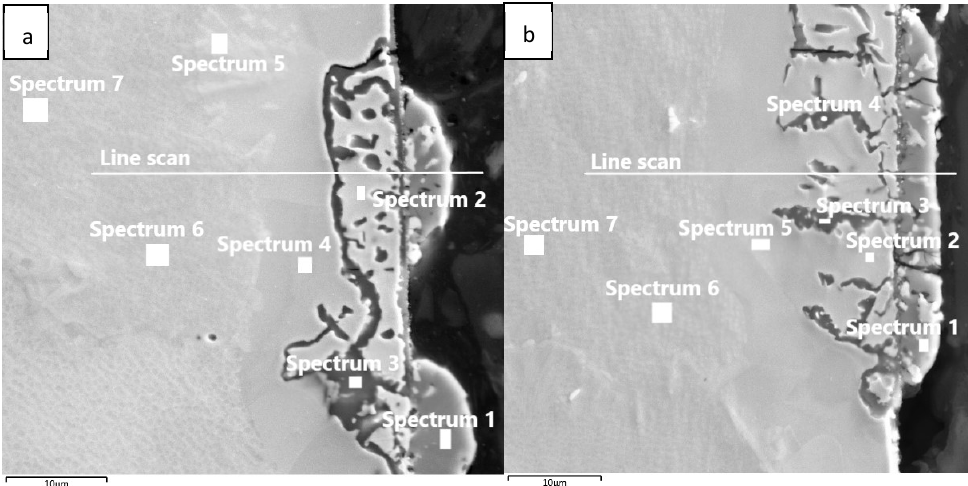
Figure 7. EDX point analysis of IN738 after He exposure, with Inconel phase and oxides on the surface: ( a ) 50R; ( b ) 100R. The chemical composition of point analysis is graphically represented in Diagrams 1, 2. Diagram 1. Chemical composition [wt.%] of IN738—50R after He exposure.